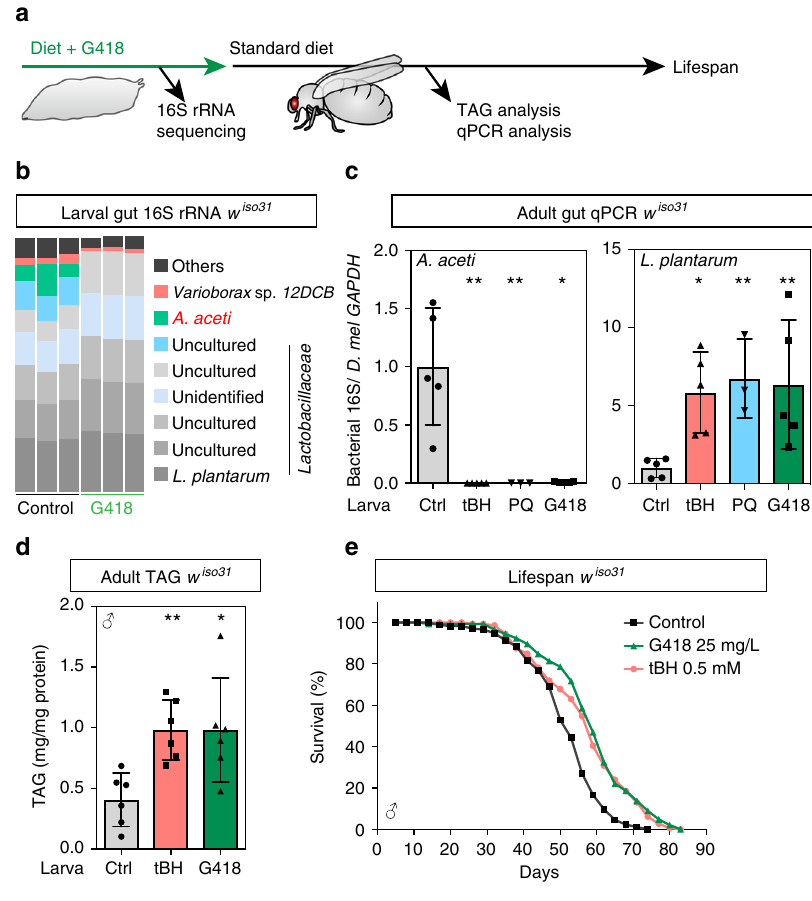
Fig. 4 Acetobacter decreases TAG stores and shortens lifespan. a Experimental strategy for G418 treatment. b 16S rRNA-sequencing analysis of G418 (25 mg/L)-treated w iso31 larval guts. Each column represents a biological replicate and colours indicate OTUs. c Quantitative PCR using species-speci fi c primers of bacteria in w iso31 male fl ies raised on tBH (0.5 mM, red), paraquat (PQ; 1 mM, blue) or G418 (25 mg/L, green). Mean ± SEM ( n = 5 except PQ ( n = 3)). d , e Whole-body TAG ( d ) or lifespan ( e ) of w iso31 male fl ies raised on tBH (0.5 mM, red) or G418 (25 mg/L, green). Mean ± SEM ( n = 6). * p < 0.05, ** p < 0.01. Statistics for survival curves are shown in Supplementary Table 1